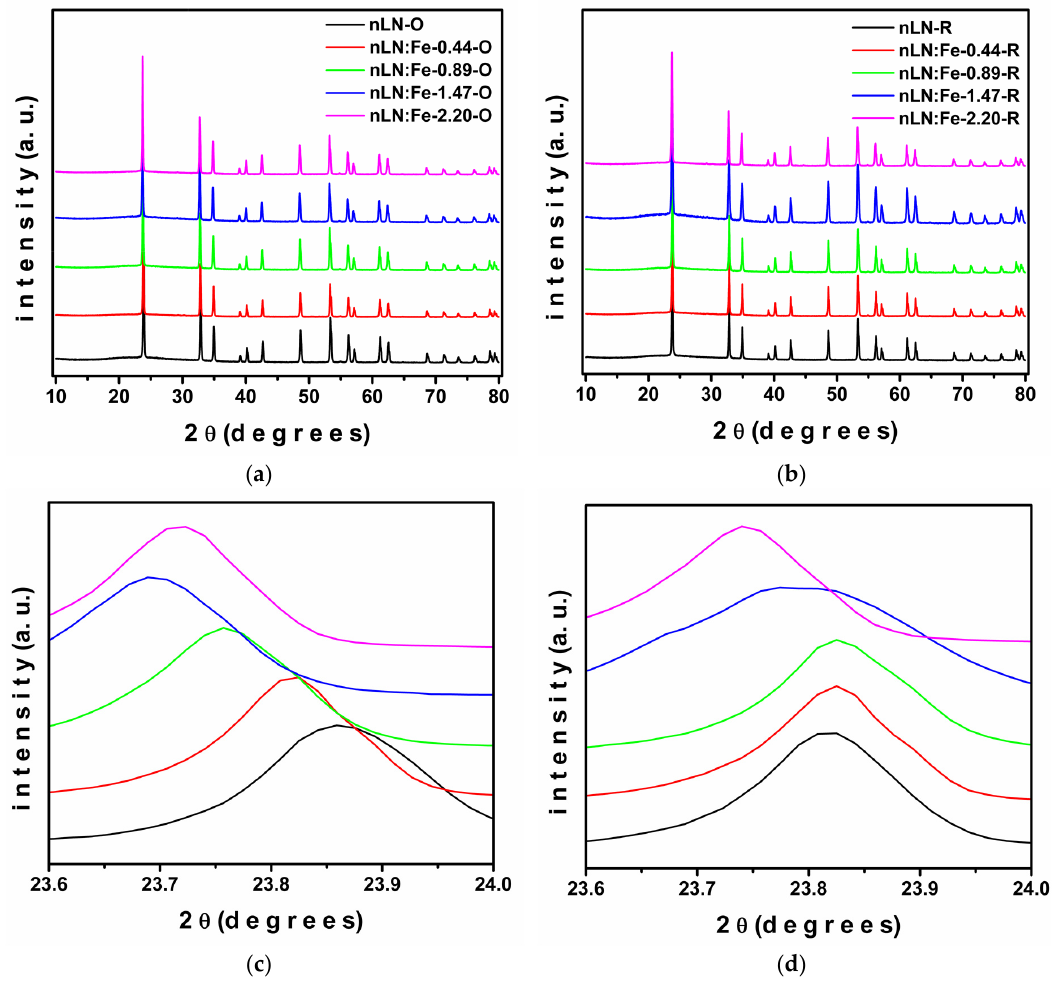
Figure 2. X-ray diffraction patterns of samples obtained after Fe-doping and application of thermal treatments TTAH and TTAO: ( a ) Oxidized samples (TTAO); ( b ) Reduced samples (TTAH); ( c , d ) Enlarged view of the respective (0 1 2) Bragg peaks.